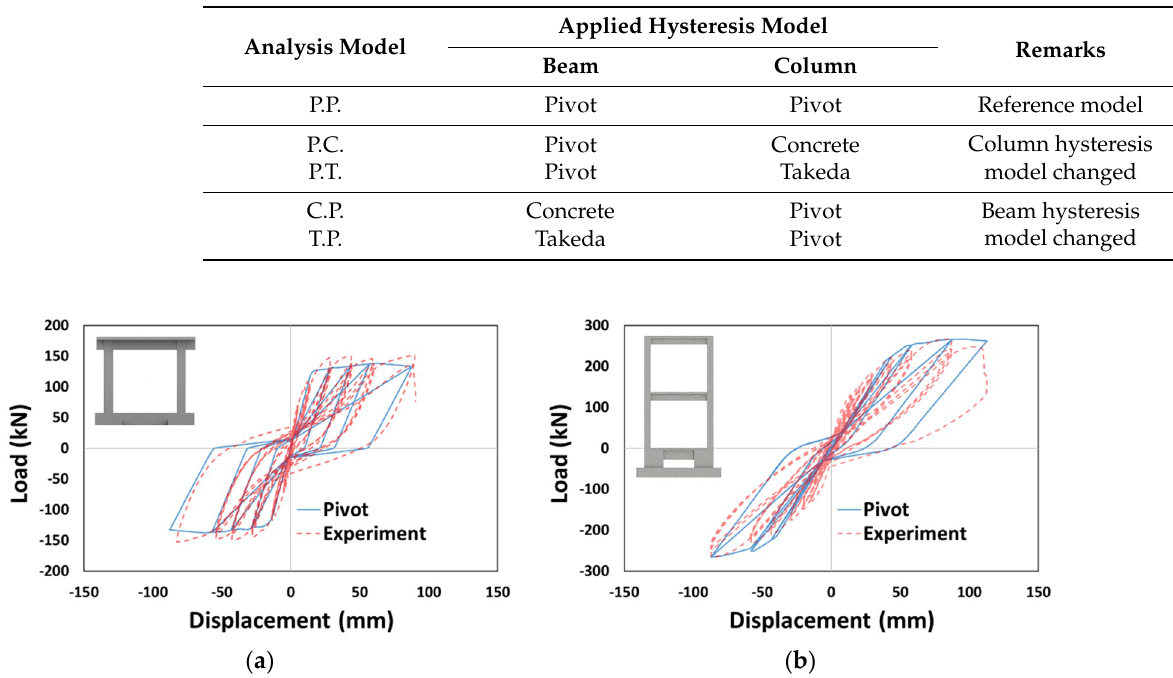
Figure 2. The 3D model of the analysis structure: ( a ) Type 1, ( b ) Type 2, and ( c ) Type 3.